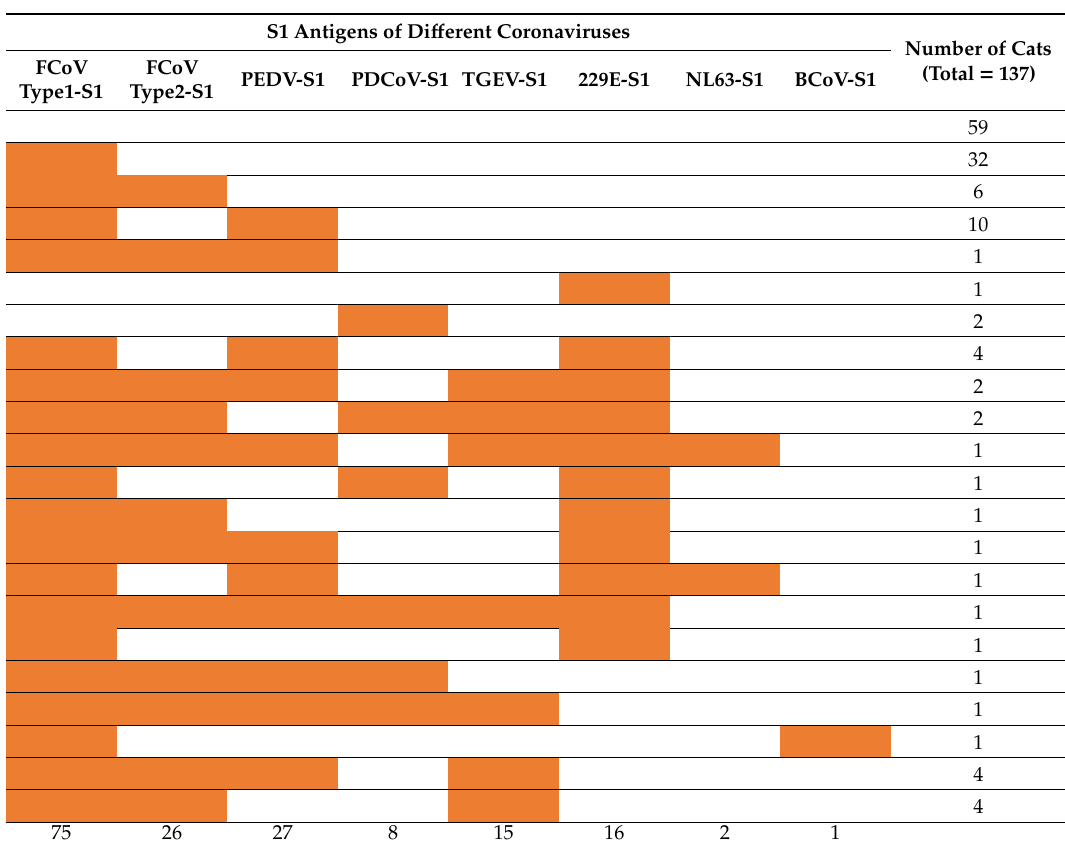
Table 1. Numbers of positive cat samples and di ff erent combinations of reactivity found. The number of positive sera against each individual S1 is shown in the bottom row. Positive ELISA reactions are colored in orange. Cut-o ff value was determined as the 5-fold over the OD450 of negative